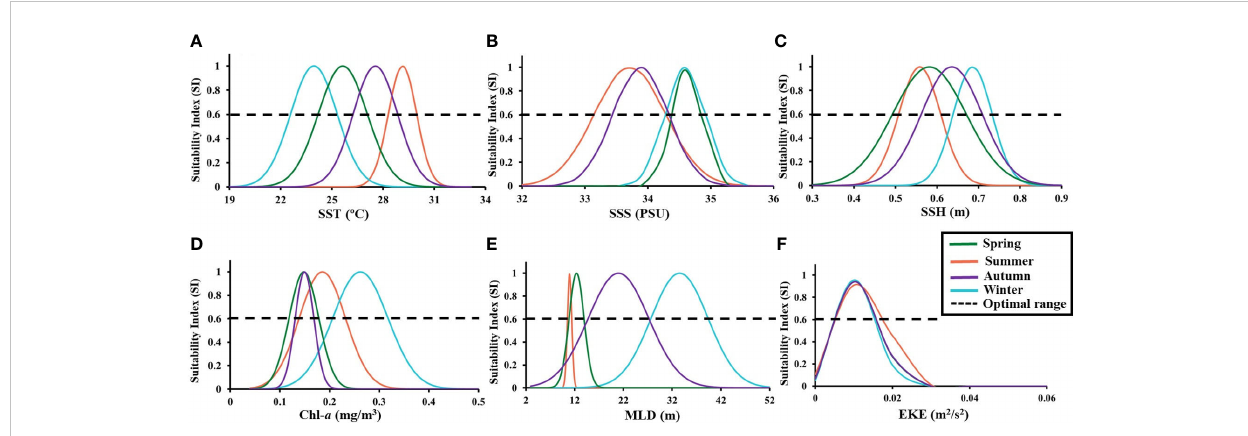
FIGURE 8 Suitability index curves fi tted to the relationship between fi shing effort for greater amberjack and all the environmental variable, that is, (A) sea surface temperature (SST), (B) sea surface salinity (SSS), (C) sea surface height (SSH), (D) sea surface chlorophyll- a (Chl- a ), (E) mixed layer depth (MLD), and (F) eddy kinetic energy (EKE), in each season. The intersections of the SI curve and the horizontal dashed lines (SI = 0.6) are the optimal range for all the environmental